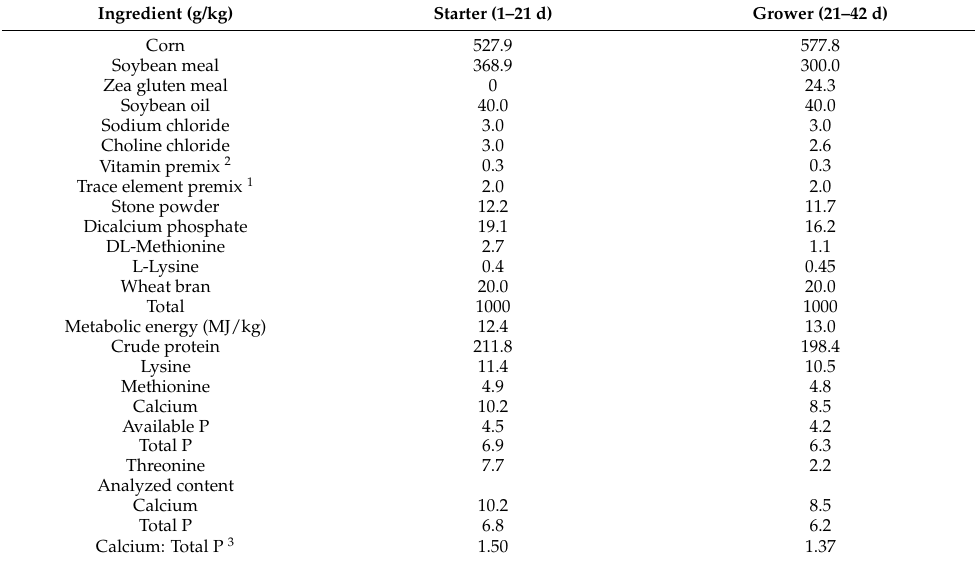
Table 1. Ingredients and nutrient levels in the basal